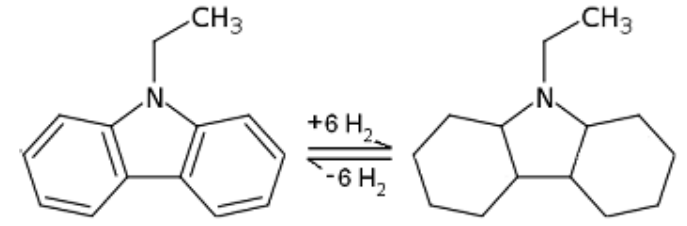
Figure 5 . Principle of the chemical storage of hydrogen